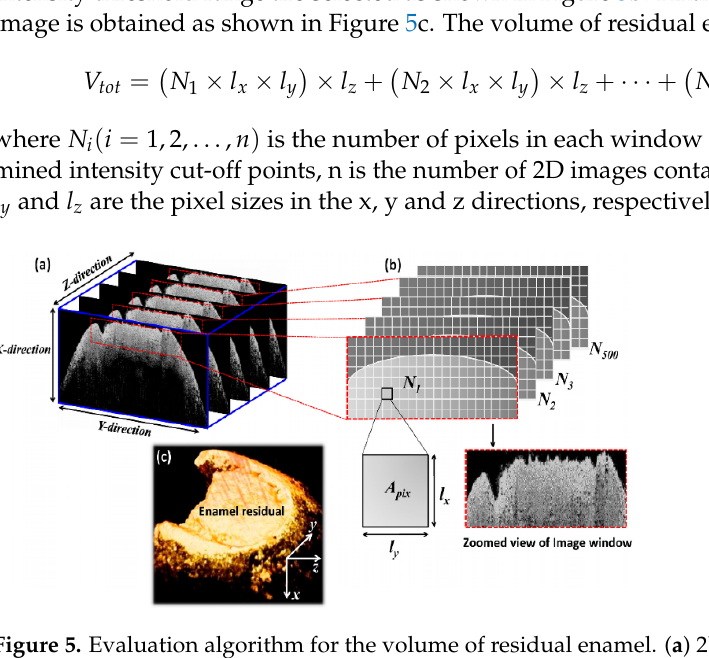
Figure 4. Variation of the surface roughness with demineralization time. This figure was adapted from [81] and was created with Microsoft Word (Microsoft Corp., Redmond, WA, USA).